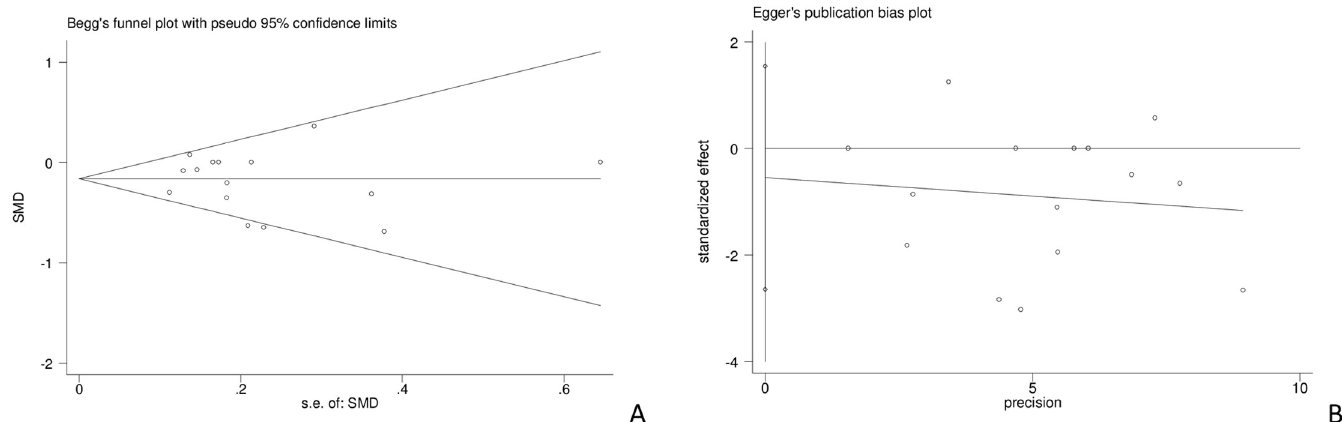
Fig 8. Begg’s funnel plot (A) and Egger’s publication bias plot (B) for detecting publication bias.